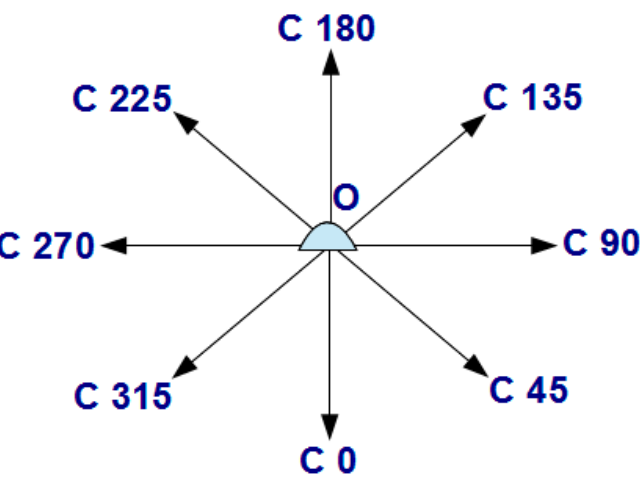
Figure 4. The adjustment of light distribution angle in the C half plane.